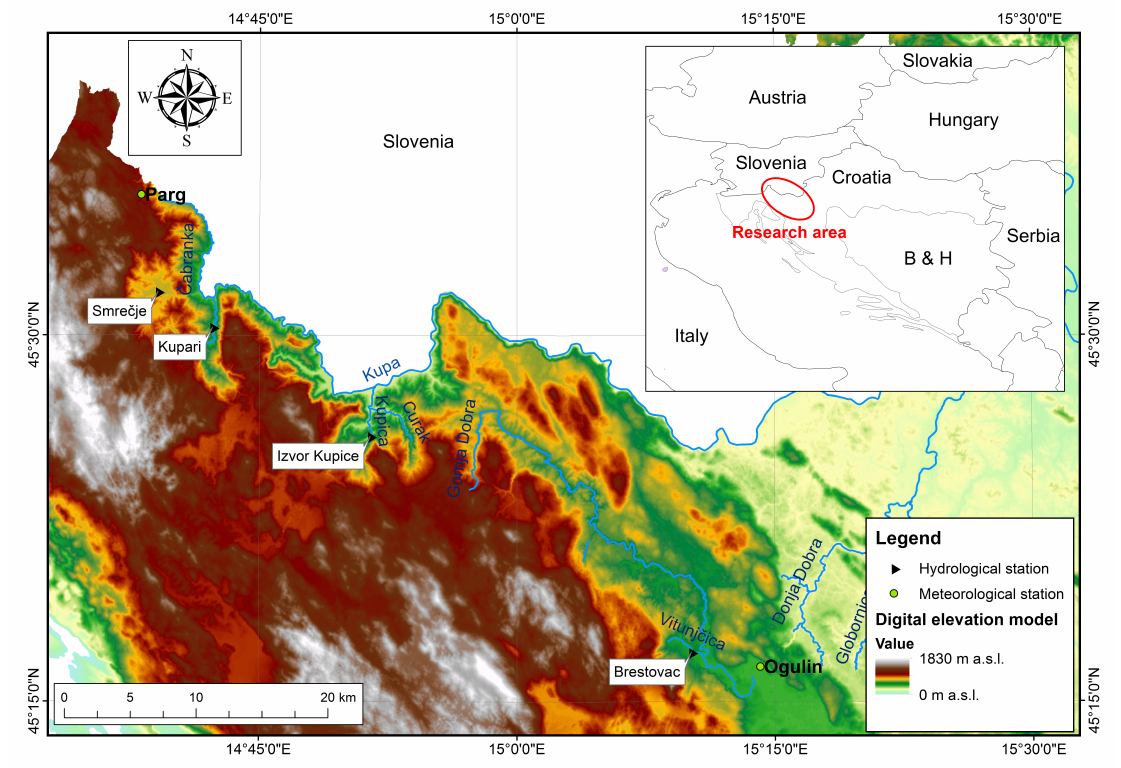
Figure 1. Study area located in the mountainous area of the northern part of the Dinaric karst of